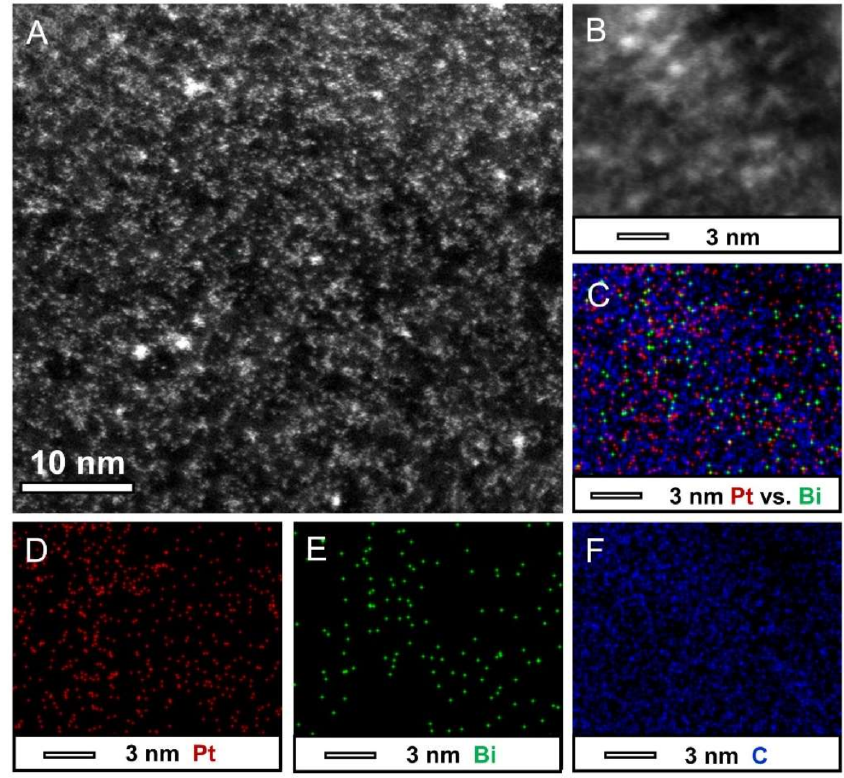
Figure 4. HRTEM images, HAADF-STEM, and EDS element mapping images of ultra-small Pt/Bi/rGO. ( A ) HRTEM images of ultra-small Pt/Bi/rGO, ( B ) HAADF-STEM-EDS mapping image, ( C ) overlapped image, and ( D – F ) HAADF-STEM-EDS elemental mapping images for Pt, Bi, and C, respectively, taken for the area in ( B